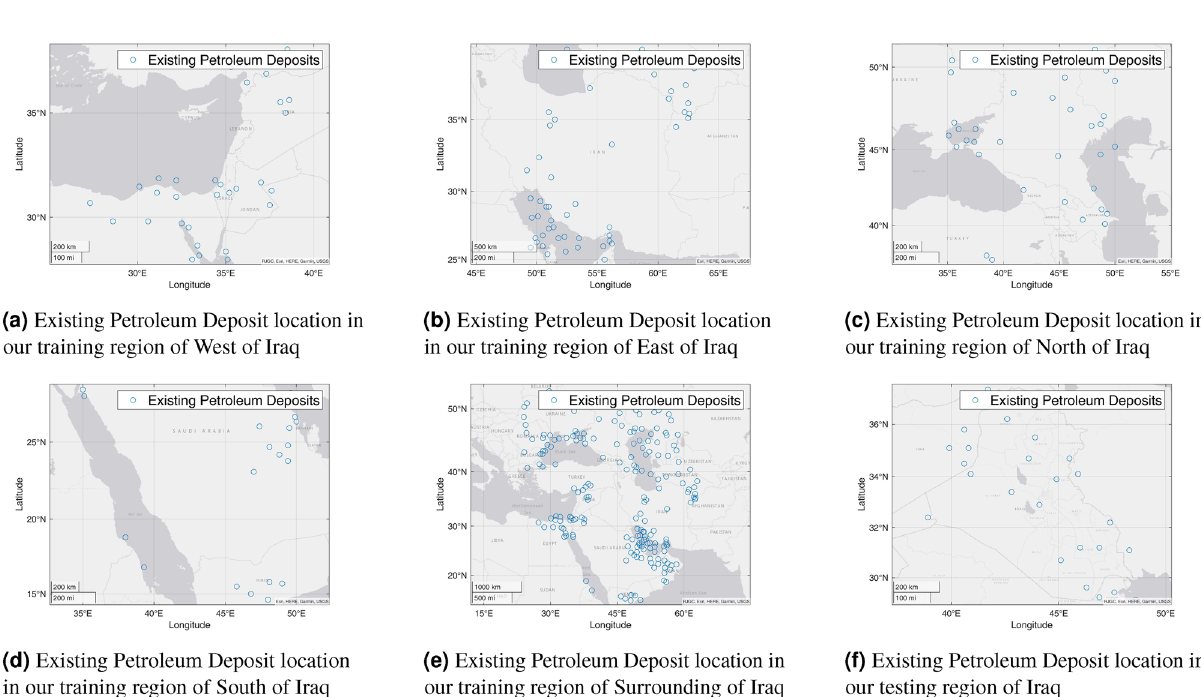
Figure 4. Existing petroleum deposit locations of our training and testing regions (the figures are created using MATLAB 2021a 51 ).